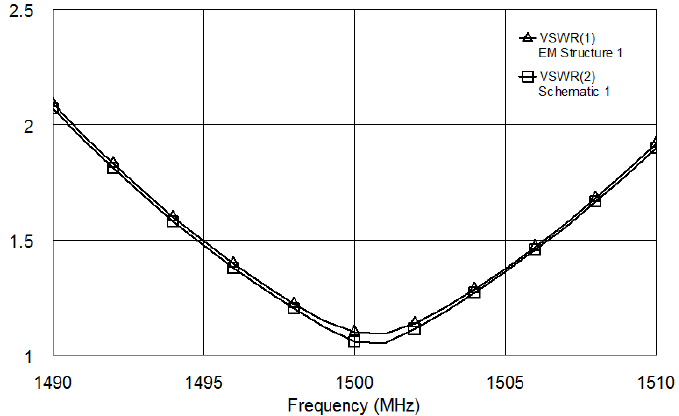
Fig. 5. The results of modeling VSWR dependence of antenna input port on frequency in passive and active modes.